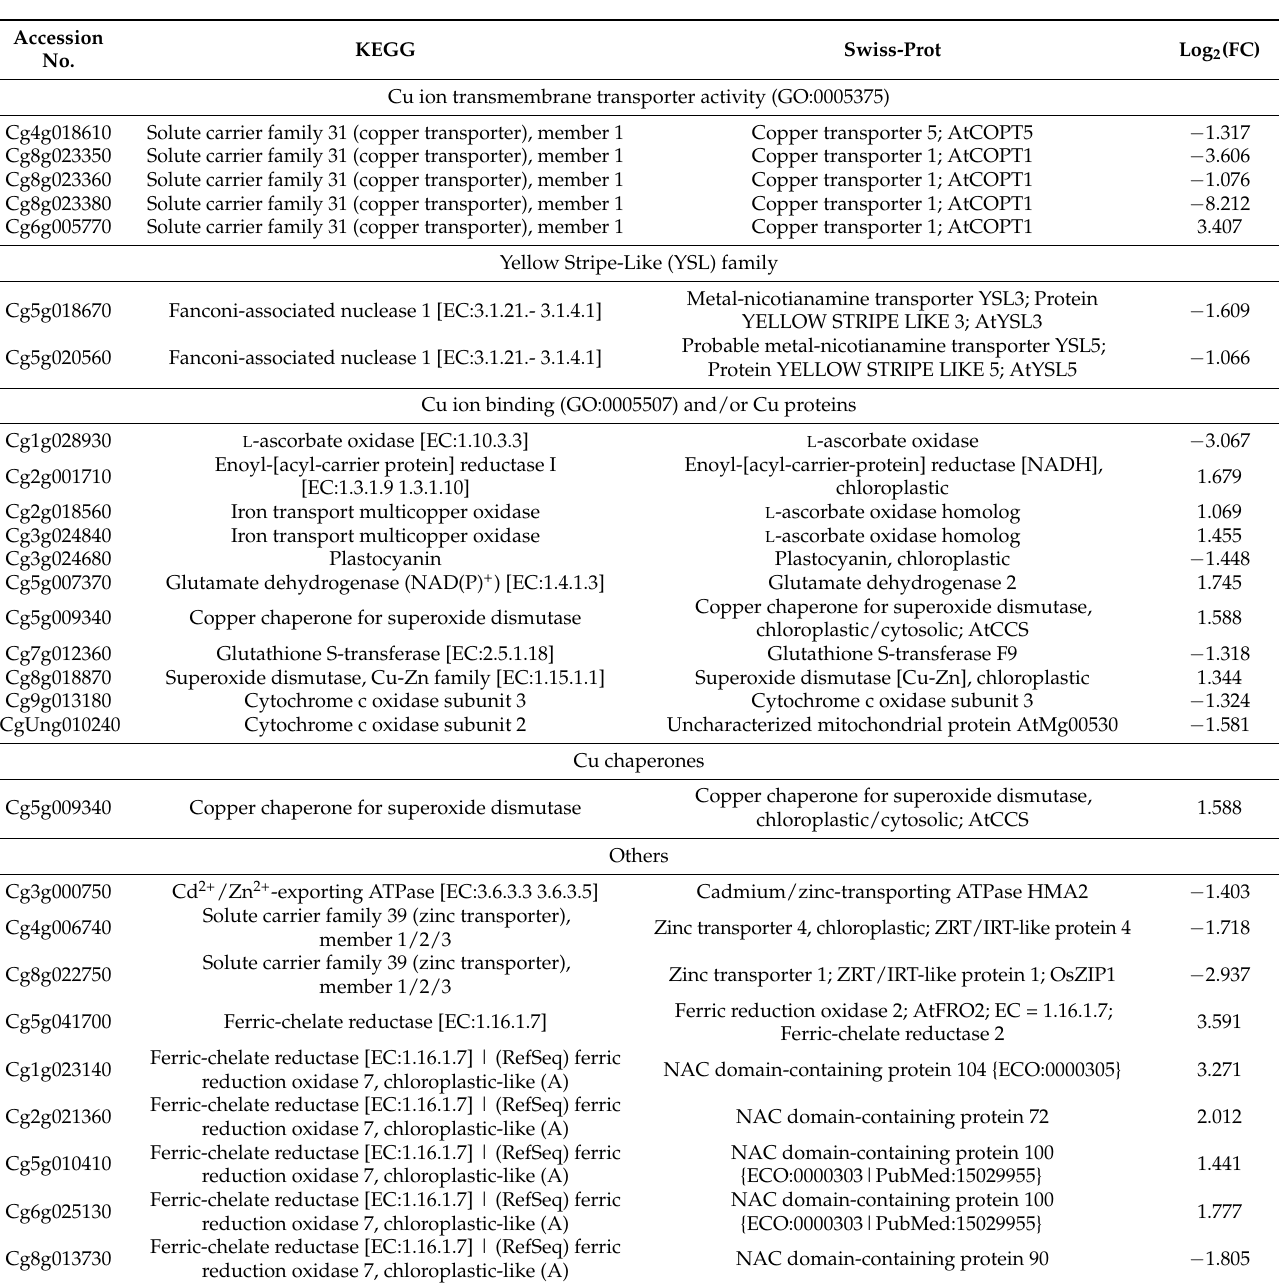
Table 1. DEGs related to Cu homeostasis in